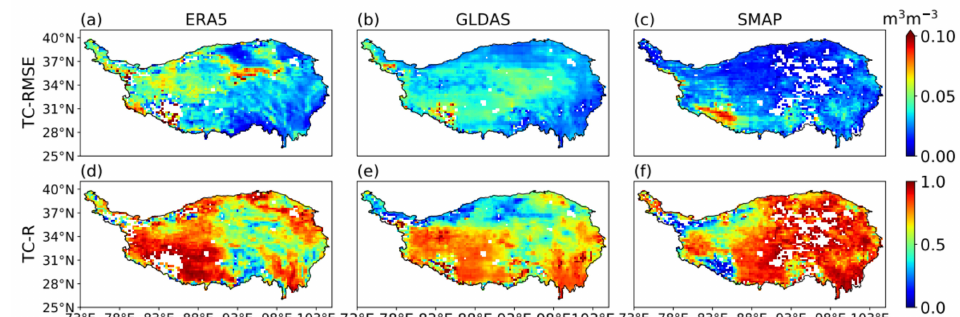
Figure 6. Spatial distribution of ( a – c ) the standard deviation of random errors derived from triple collocation (TC-RMSE) and ( d – f ) triple collocation correlation coefficients (TC-R) for (left column) the fifth-generation European Centre for Medium-Range Weather Forecasts atmospheric reanalysis (ERA5), (central column) Global Land Data Assimilation System (GLDAS), and (right column) Soil Moisture Active Passive (SMAP) datasets.